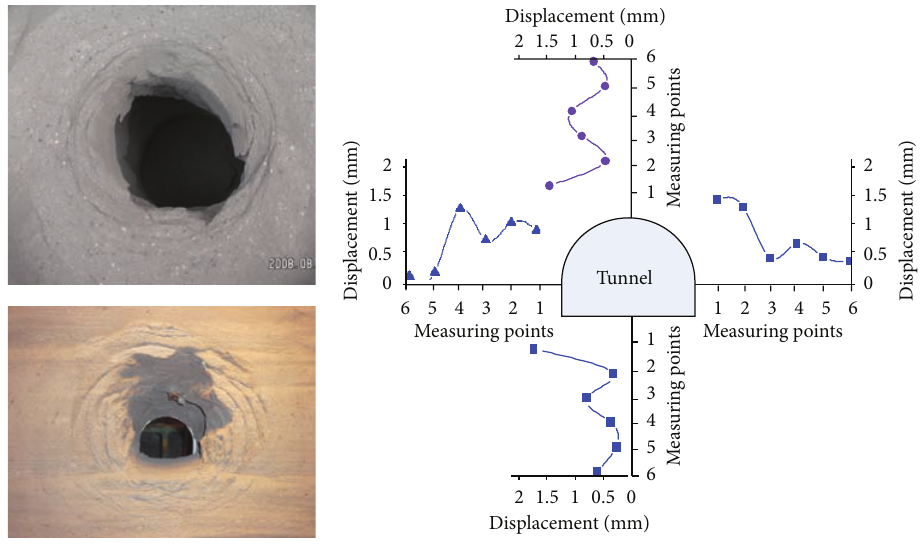
Figure 5: Results of the model test.